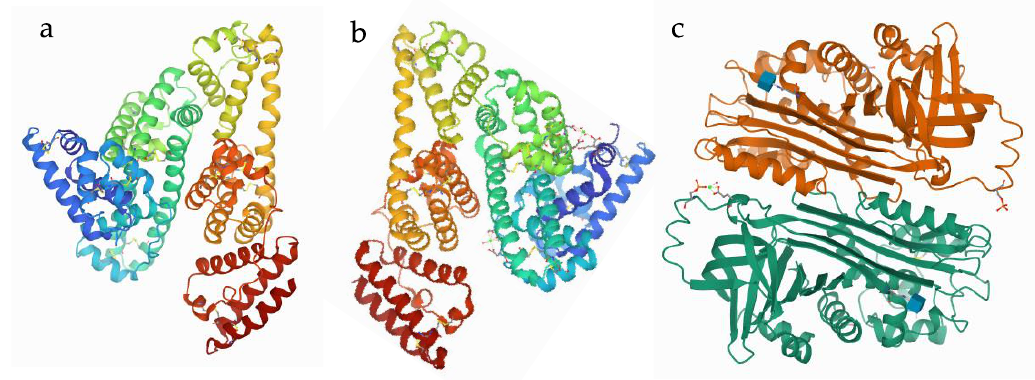
Figure 1. The 3D structure of albumins: ( a ) human serum albumin; ( b ) bovine serum albumin and ( c ) ovalbumin [49].